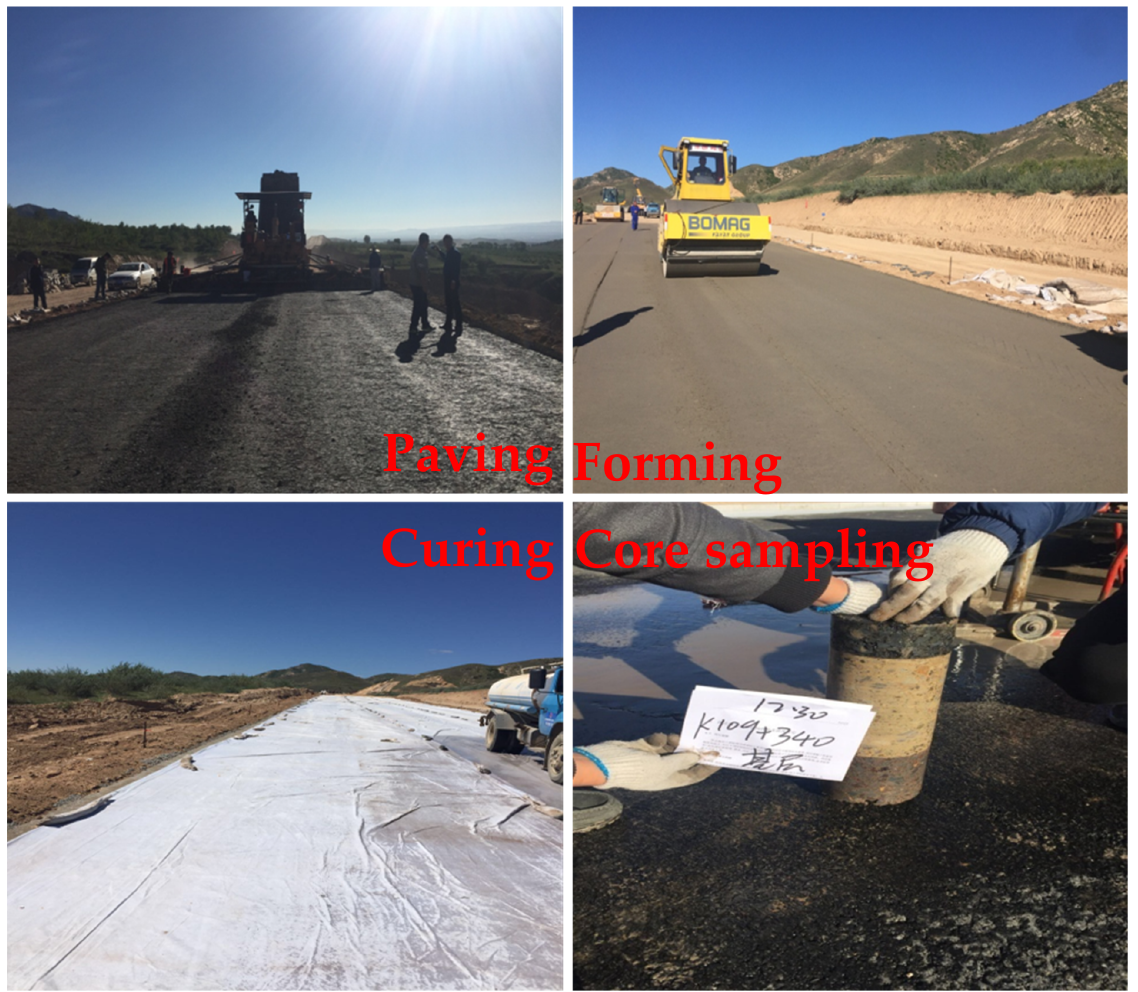
Figure 9. Field picture of the pilot test.